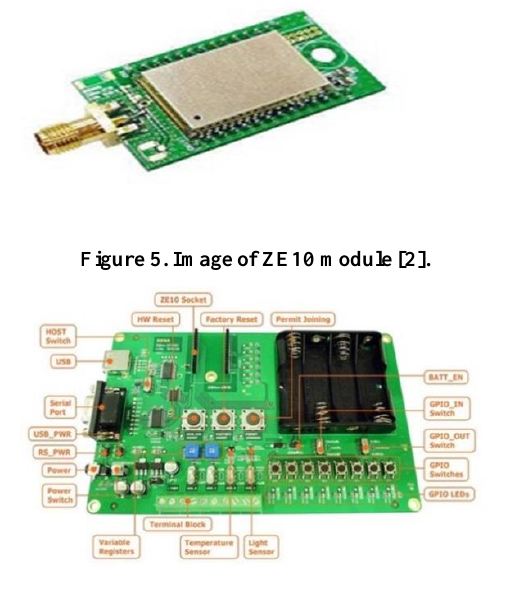
Figure 6. Image of ZE10 development board [2].